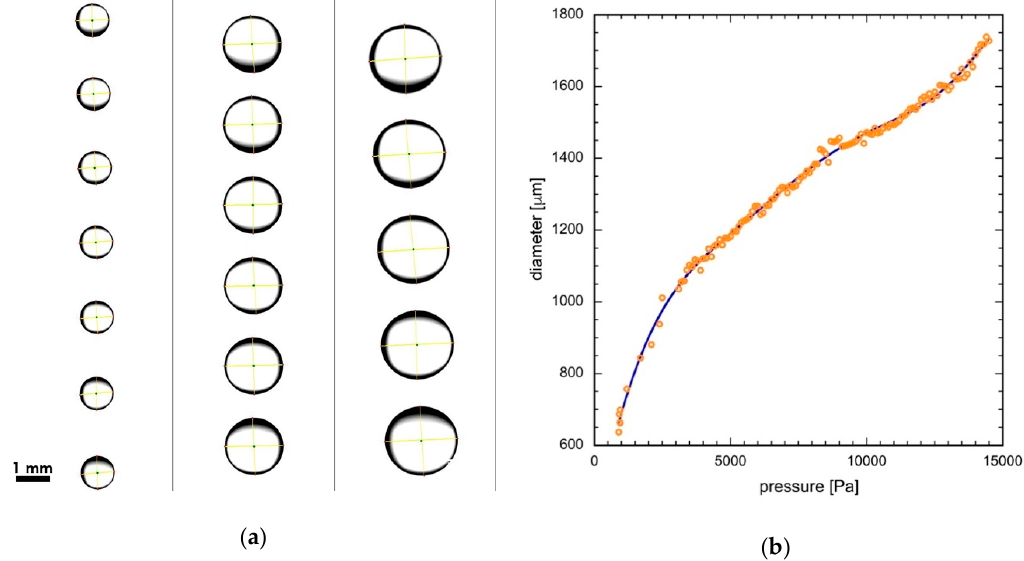
Figure 3. ( a ) Sequences of photos presenting rising droplet of different sizes after automatic analysis in developed software (time interval between subsequent droplet positions for each sequence is different); ( b ) Single droplet diameter as a function of overpressure inside the oil cell (servo-valve opening time 0.3 s).